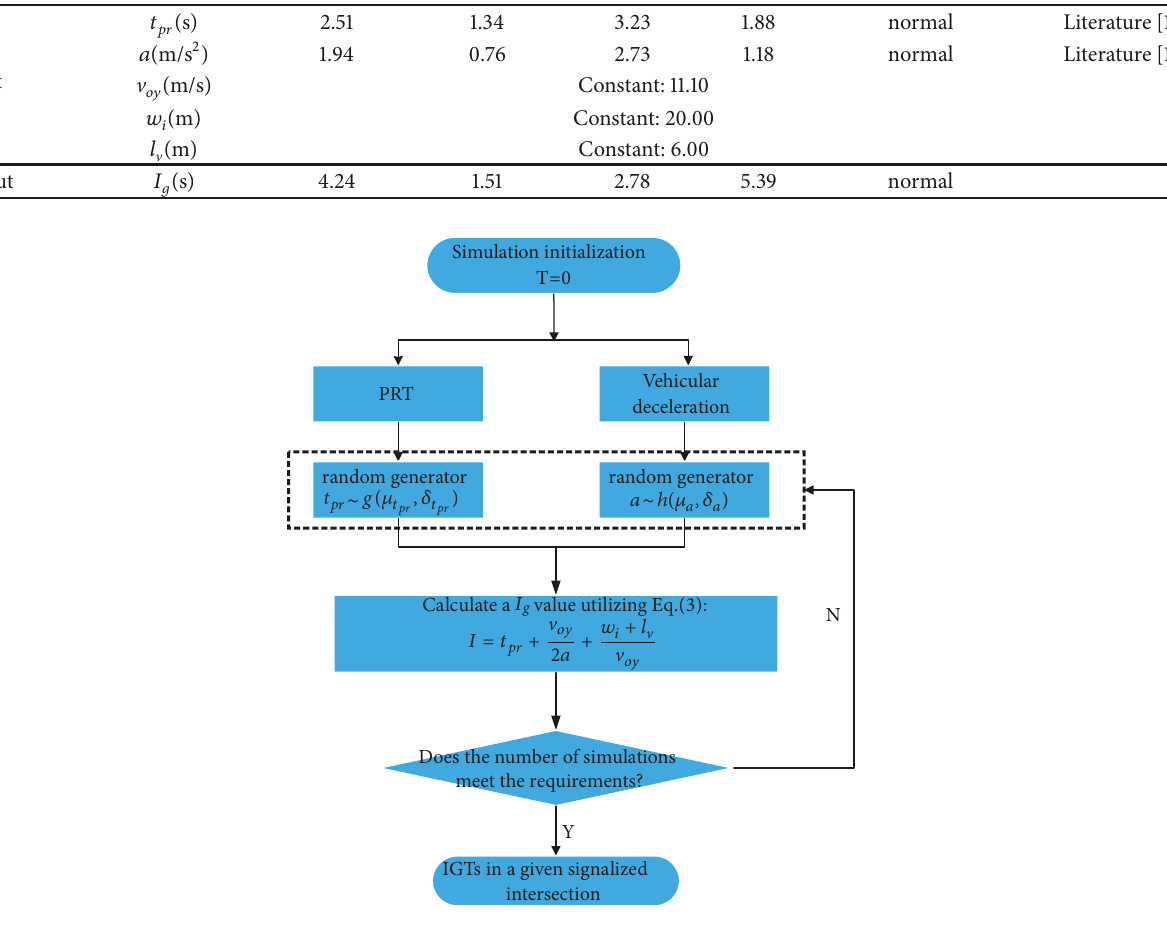
Figure 4: The key calculation procedure of the MATLAB